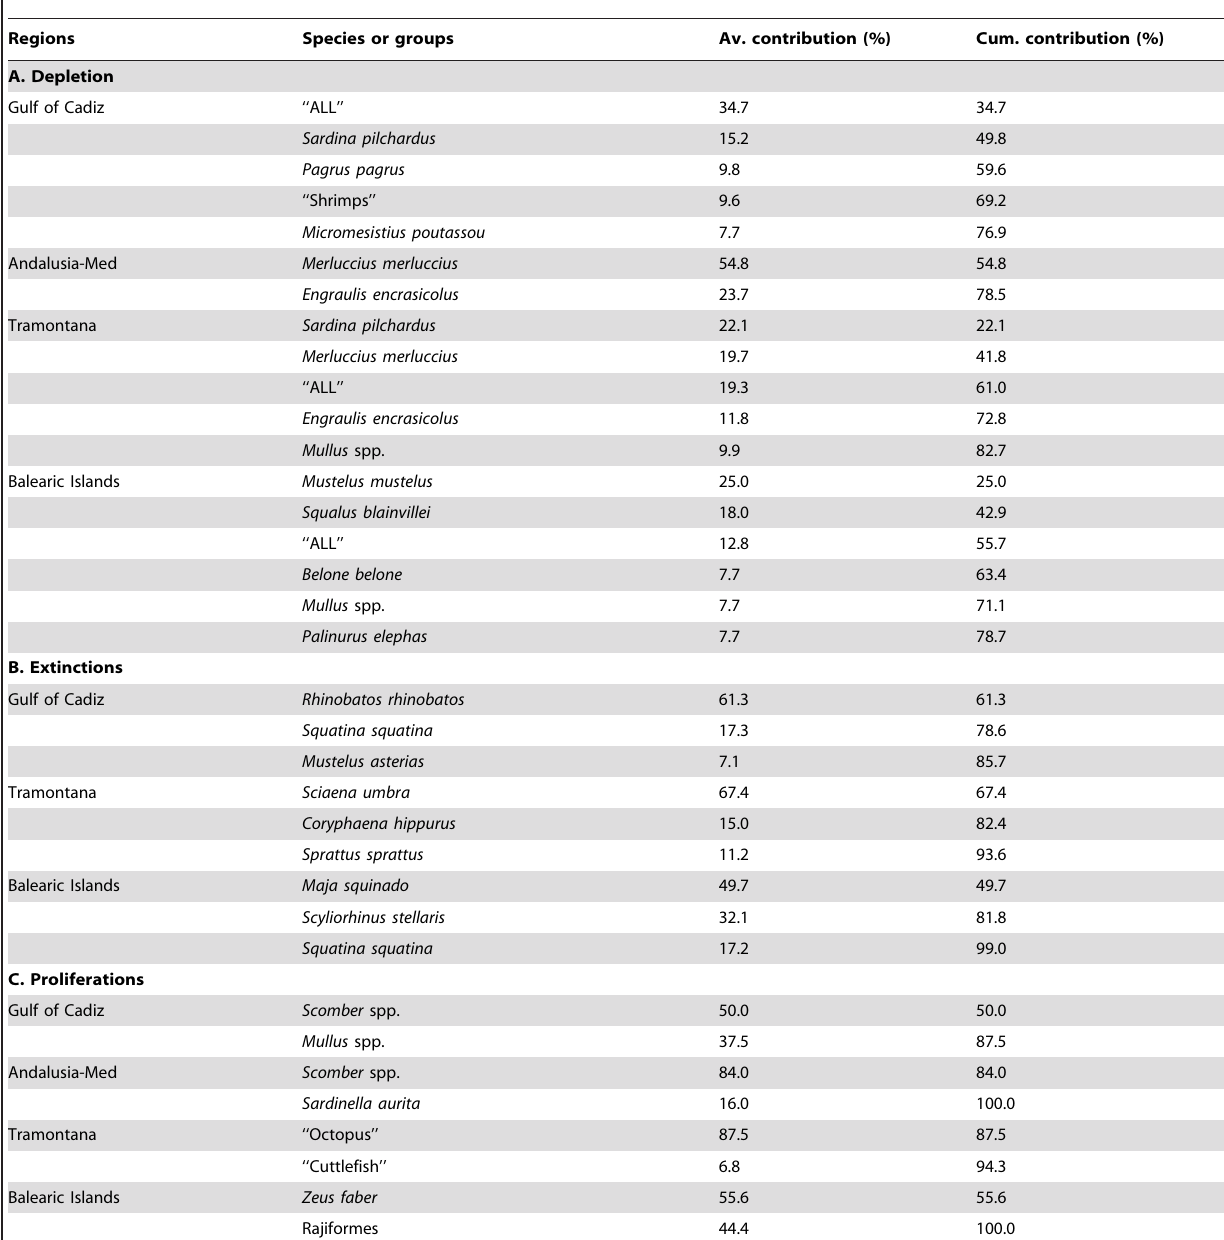
Table 4. SIMPER analysis by region and species or groups (Table 2) by depletion, local extinction, and proliferation lists.